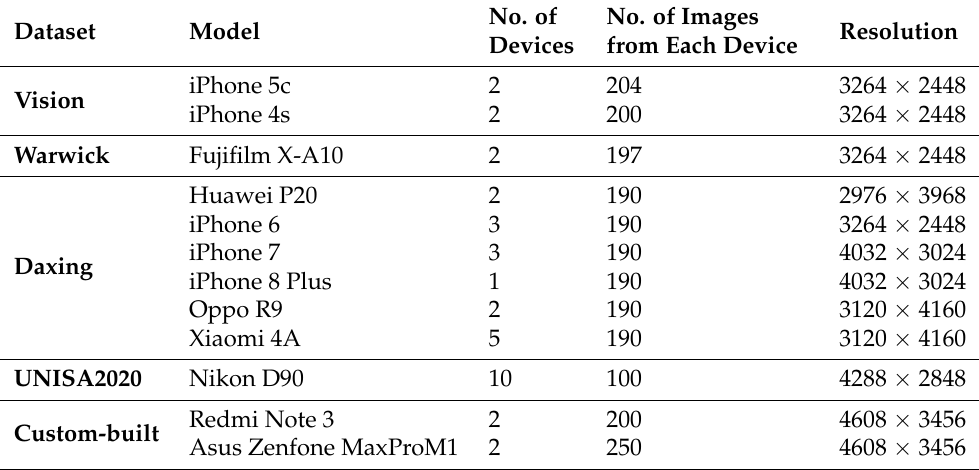
Table 1. Devices in different datasets used in our experiments.